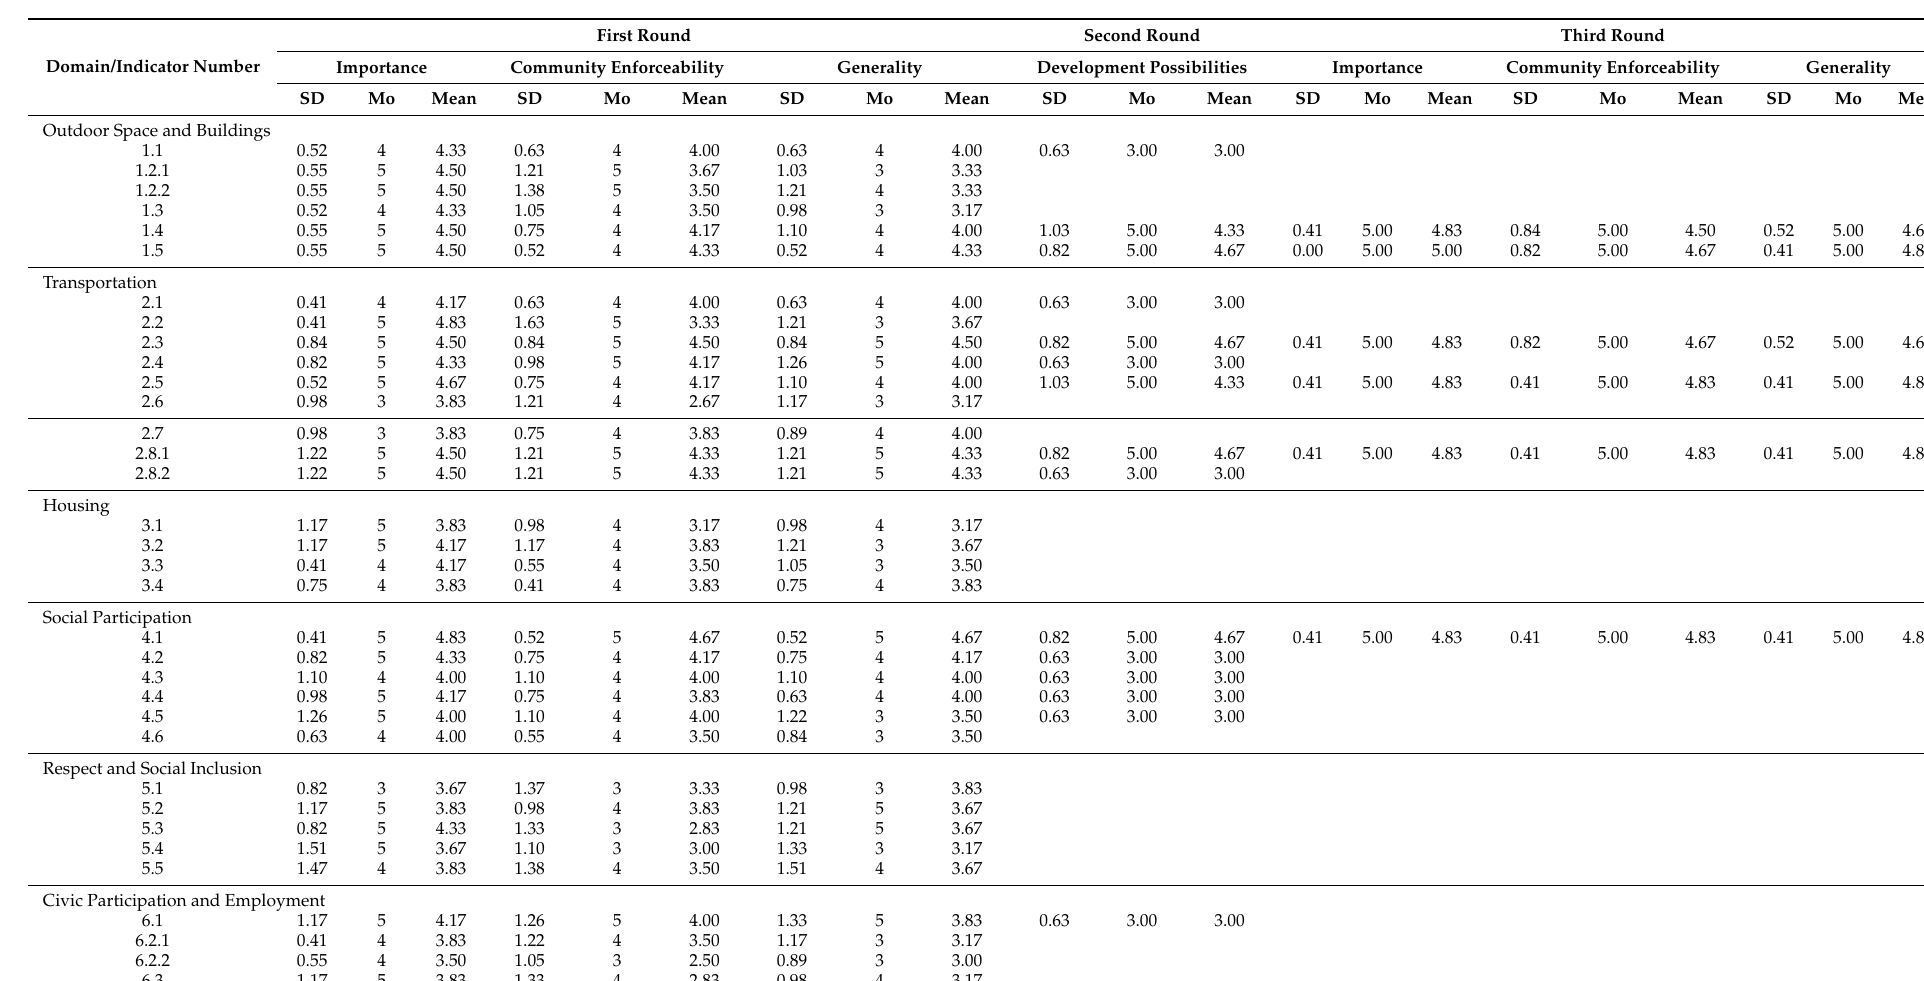
Table 1. Experts’ evaluations of indicators of age-friendliness of Taiwan’s cities based on a modified Delphi